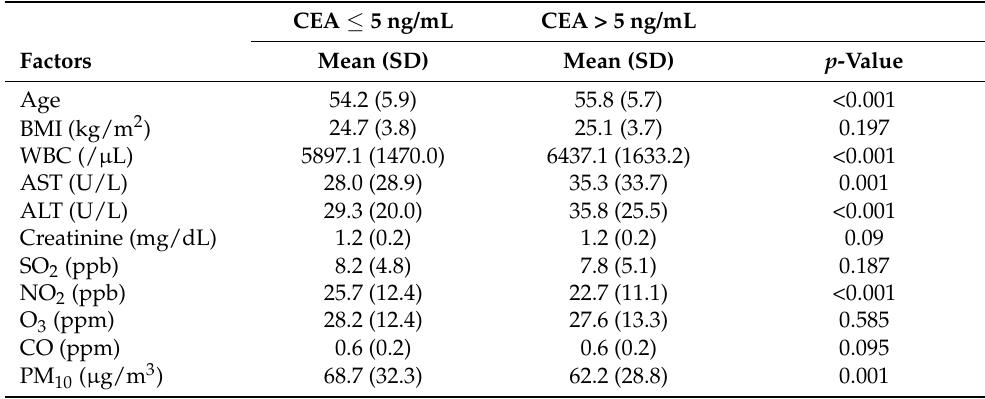
Table 2. Student t -test for Age, BMI, WBC, AST, ALT, Creatinine, Air pollution in 2 different carcinoembryonic antigen (CEA) level groups.